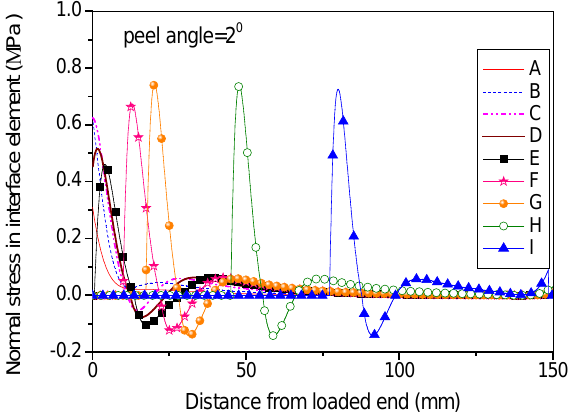
Figure 19. Normal stress distribution along the interface at different load levels when the peel angle = 2 degree.